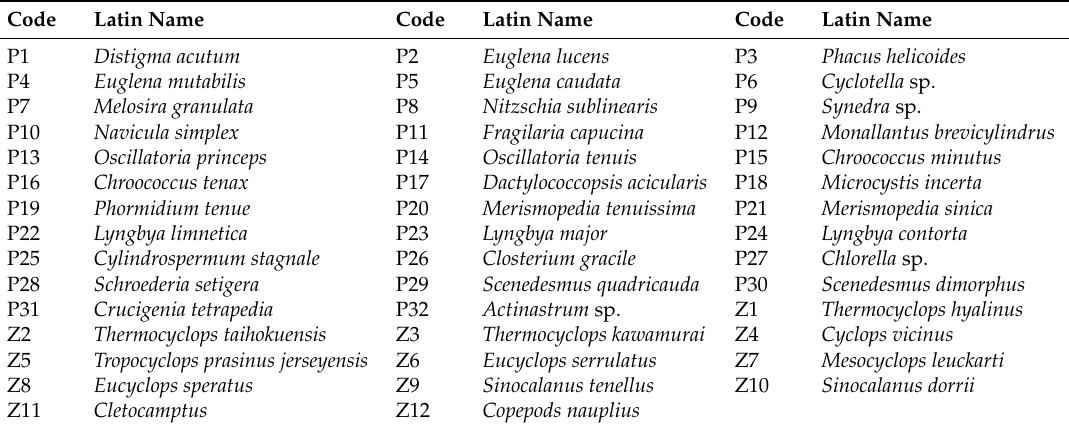
Table 5. Codes and Latin names of plankton species for